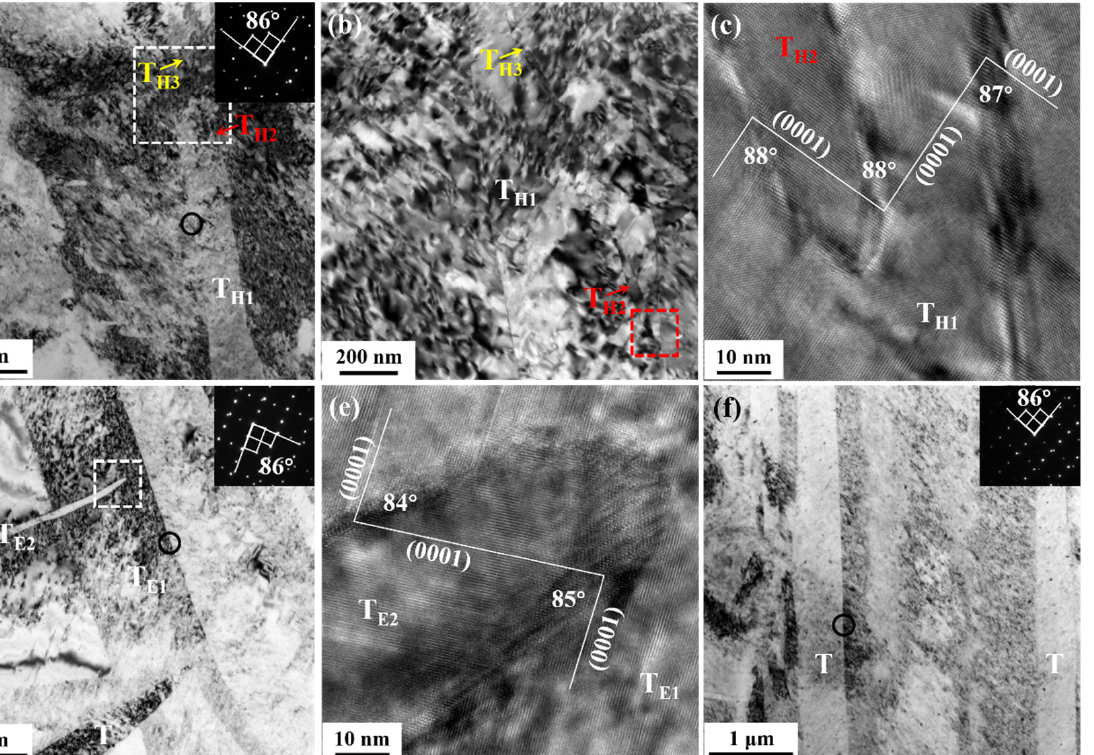
Figure 5. Microstructure in the central region of the alloy bars: ( a ) HS-3 sample; ( b ) E9S-3 sample; ( c ) E25S-3 sample. Nanoscale subgrains are indicated by the green arrows in the micrographs. Figure 6a,d show the NSGs (indicated as “NSG1” and “NSG2”, respectively) formed in HS-3 and E9S-1 samples, respectively. The grain sizes of NSG1 and NSG2 were ~80 nm. Both the boundary 1 (B 1 ) of NSG1 and the boundary 3 (B 3 ) of NSG2 had a misorientation of about 78°, which belongs to an abnormal {101 (cid:3364) 2} tension twin boundary [23,24]. The